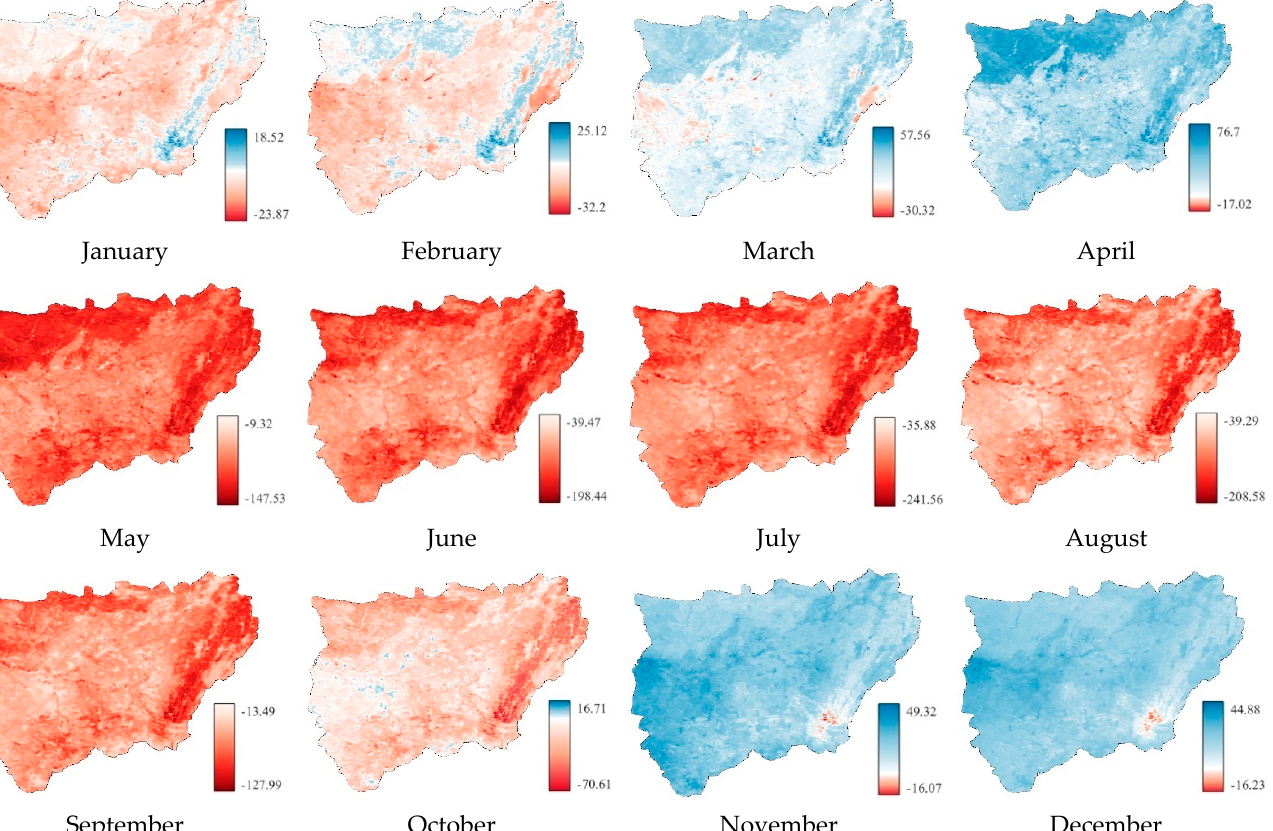
Figure 12. Monthly variation in water balance ( Δ W).